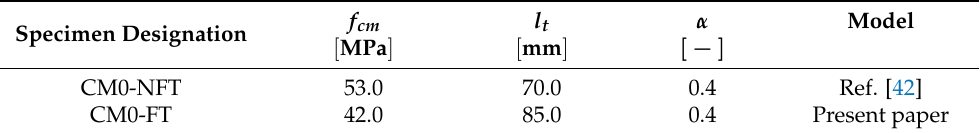
Table 3. Calibration of the input data for unconditioned CM0 specimens (labelled CM0-NFT) and for conditioned CM0 specimens (labelled CM0-FT) used in the previous model of Ref. [42] and in the last one, respectively.